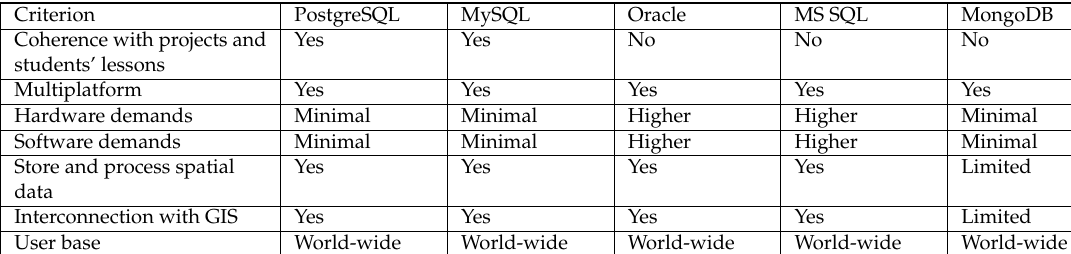
Table 1. Criteria for a select database system for the